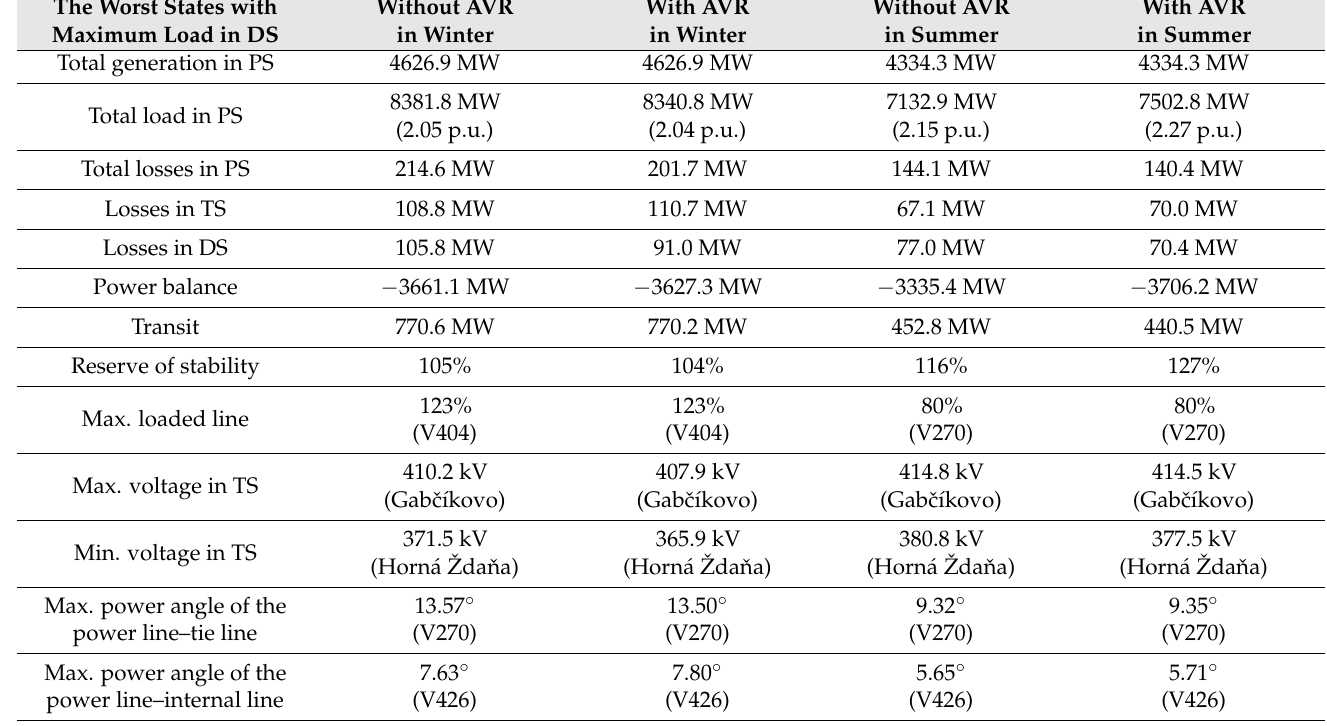
Table 3. Load flow results: worst cases with maximum load in the